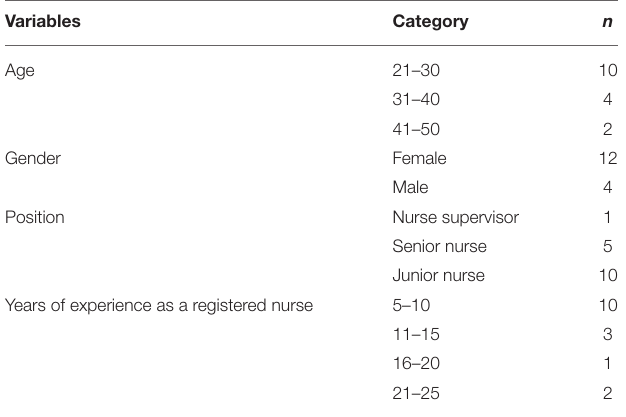
TABLE 1 | Demographic characteristics of the participating hospital nurses ( n = 16).